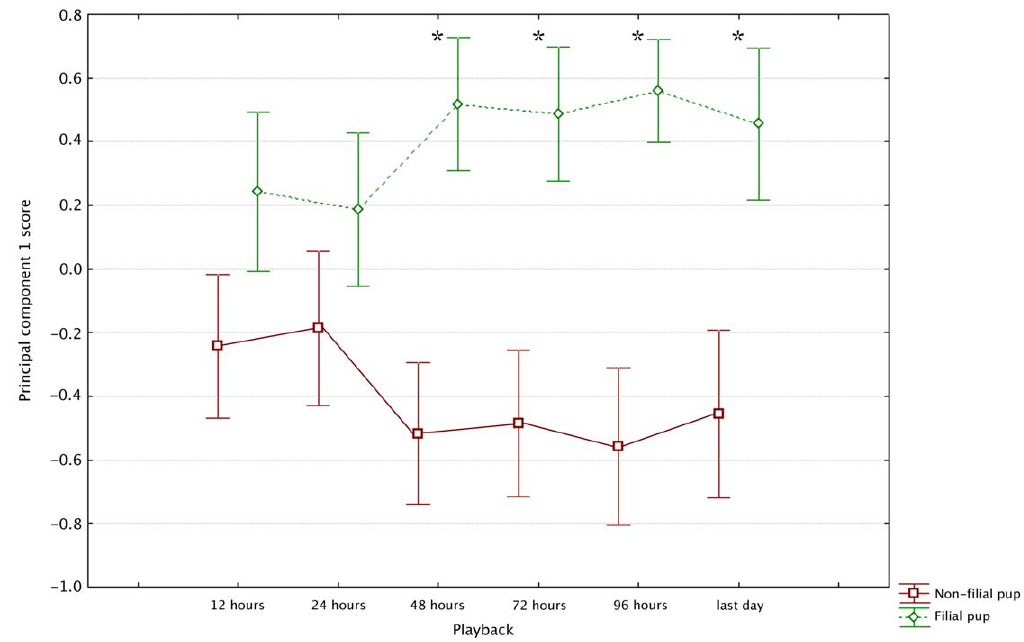
Figure 2. Comparison of composite response scores using principle component 1 of the PCA at each playback. From the first playback females show a trend to be more responsive to their filial pup’s FAC. This difference becomes significant within 48 hours of birth. See table 1 for statistics, points=mean 6 1 S.E.M. * indicates significant difference.